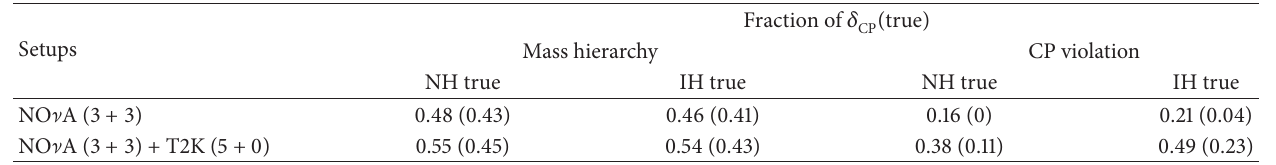
Table 2: Fractions of true values of 𝛿 for which a discovery is possible for mass hierarchy and CP violation. The numbers without (with) CP parentheses correspond to 90% (95%) CL. Here we take the central values: sin 2 𝜃 13 = 0.026 and sin 2 𝜃 23 = 0.5 . The results are shown for both NH and IH as true hierarchy. This table has been taken from [72].